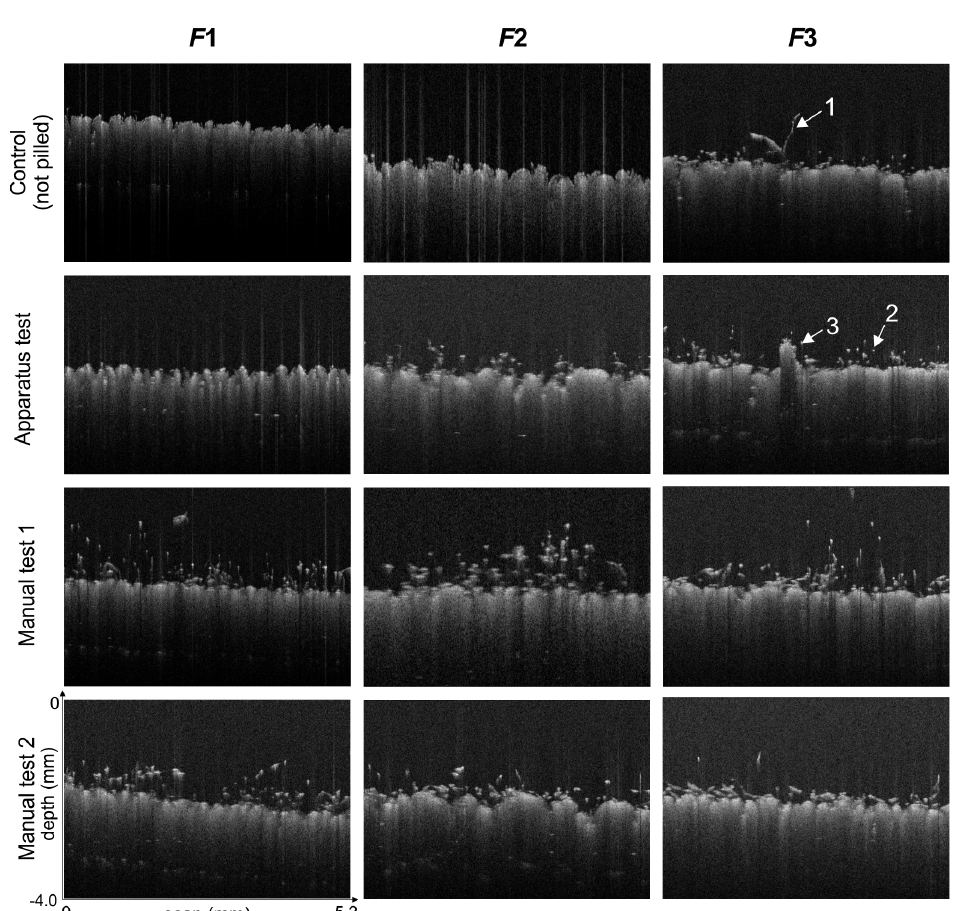
Figure 7. Exemplary two-dimensional OCT images (B-scans) of knitwear cross-sections taken from volumetric data, illustrating the appearance of a layer above the fabric in the absence of pilling (control samples of F 1 and F 2, and F 1 after standardized abrasion test), in the early stages of pilling (all tested fabrics after manual tests), and during the pilling phase after standardized abrasion test ( F 2 and F 3). 1—loose fabric fibers, 2—cut fiber fragments, 3—a pill attached to the fabric